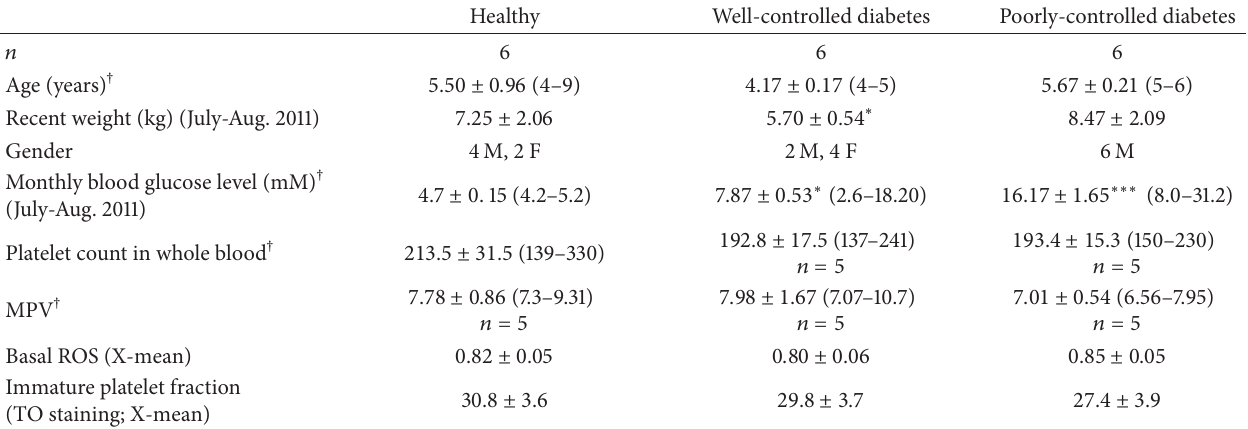
Table 1: Comparison of monkey